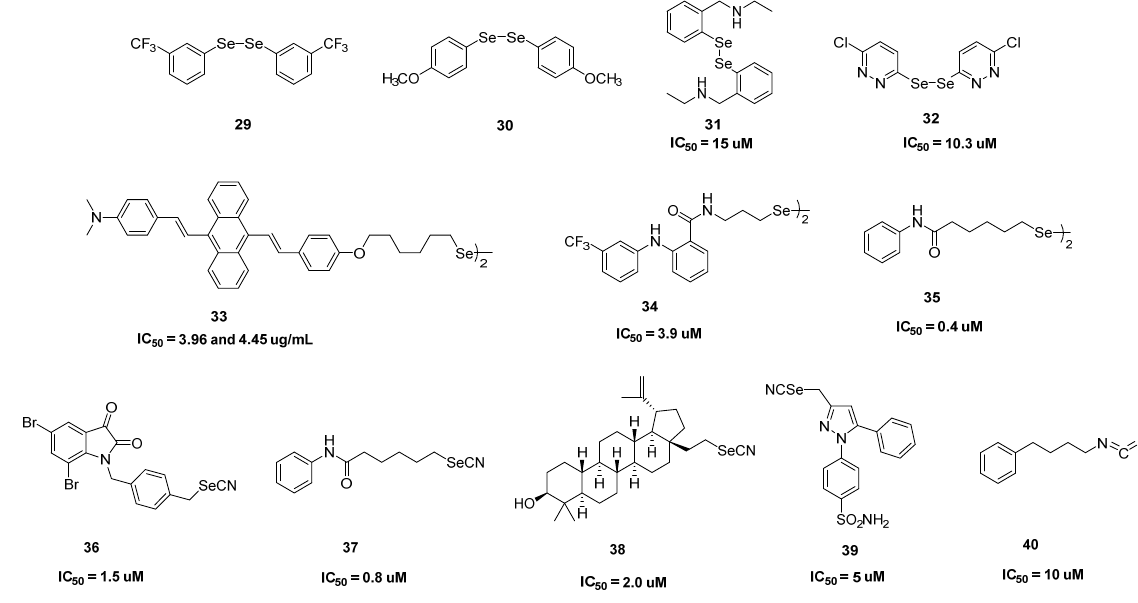
Figure 3. Structural representation of diselenides ( 29 – 35 ) [73–79] and selenocyanates ( 36 – 40 ) [79–83] for anticancer activity.